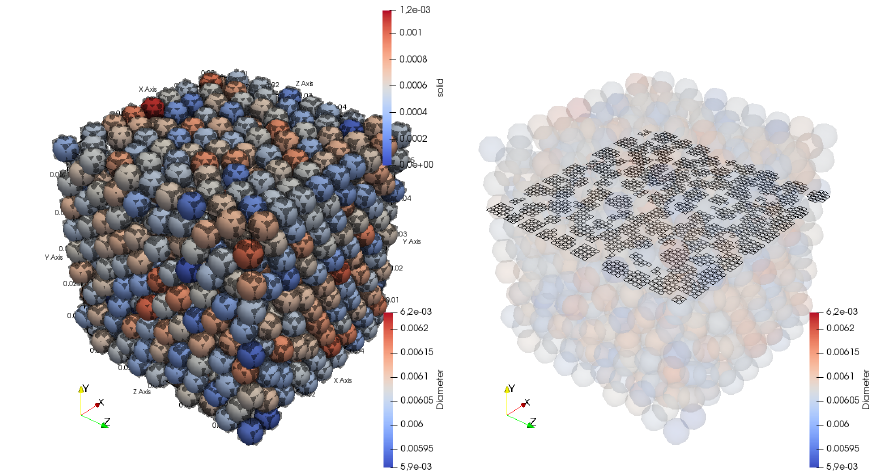
Figure 8. Virtual bed sample number 3 in resolution 50 × 50 ×